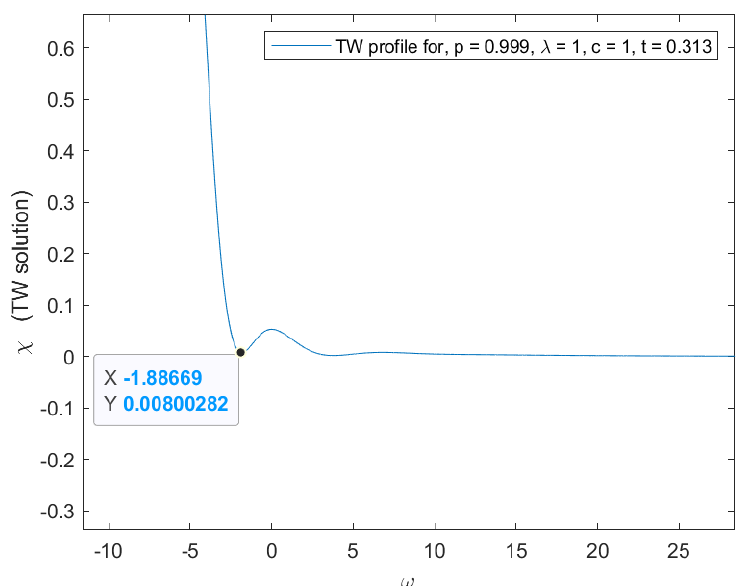
Figure 10. Positivity in the first minimum holds for p close to one (i.e., close to a Lipschitz reaction term). In this case Π = λ t = 0.313. For Π < 0.313, solution profiles have a negative first minimum. Idem for Π > 0.313, refer to Figure 11.